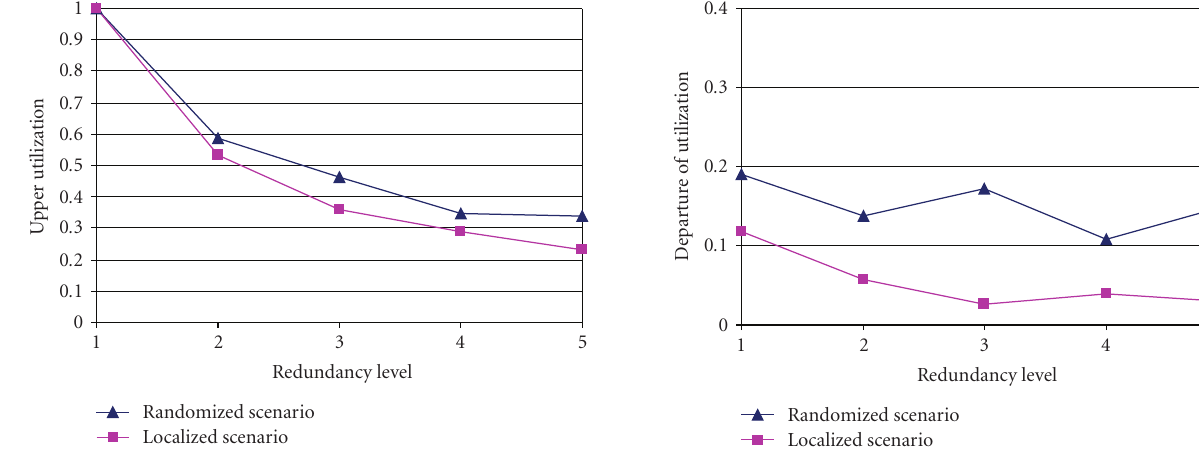
Figure 7: Departure of Utilization—Heavily